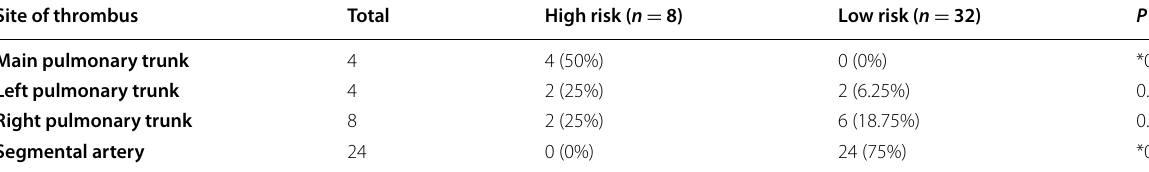
Table 5 Relation between the site of thrombosis and risk stratification of PTE